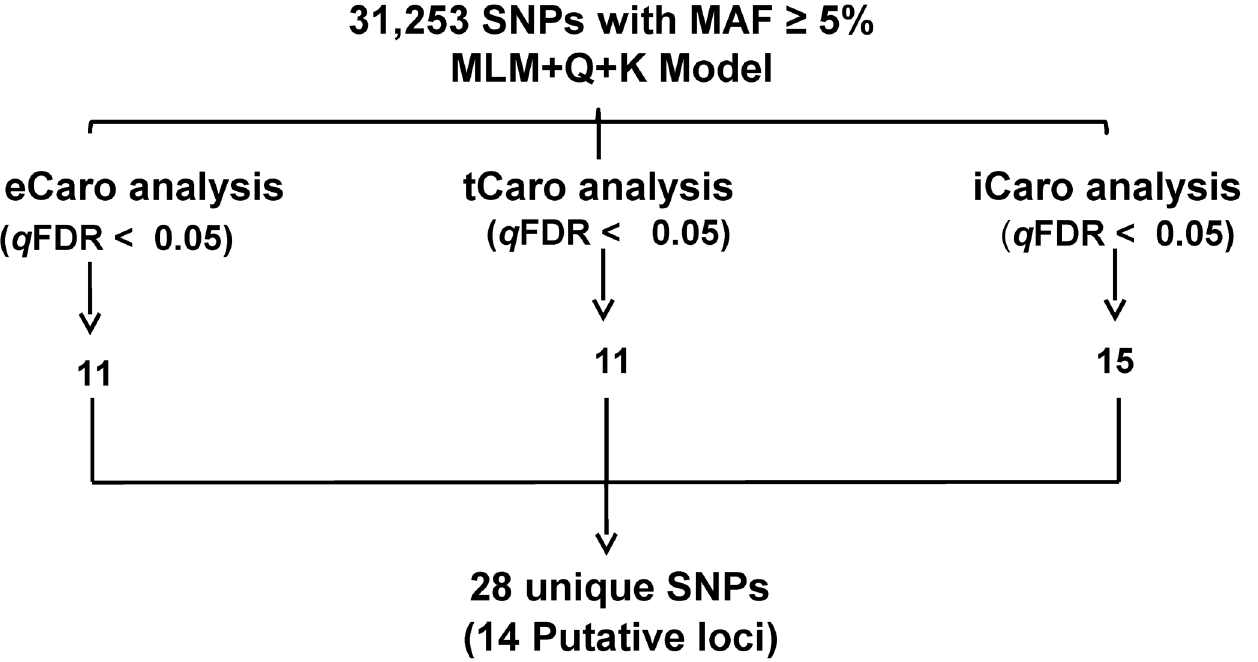
Fig 3. Flow chart showing the SNP selection for extractable carotenoid content (eCaro), wavelet transformed spectral reflectance carotenoid content (tCaro) and spectral index carotenoid content (iCaro) based on MLM+Q+K from the original 31,253 SNPs with MAF (cid:5) 5% analyzed across two years (2009 and 2010) in Columbia. For all analyses, BLUP means were used for association testing.